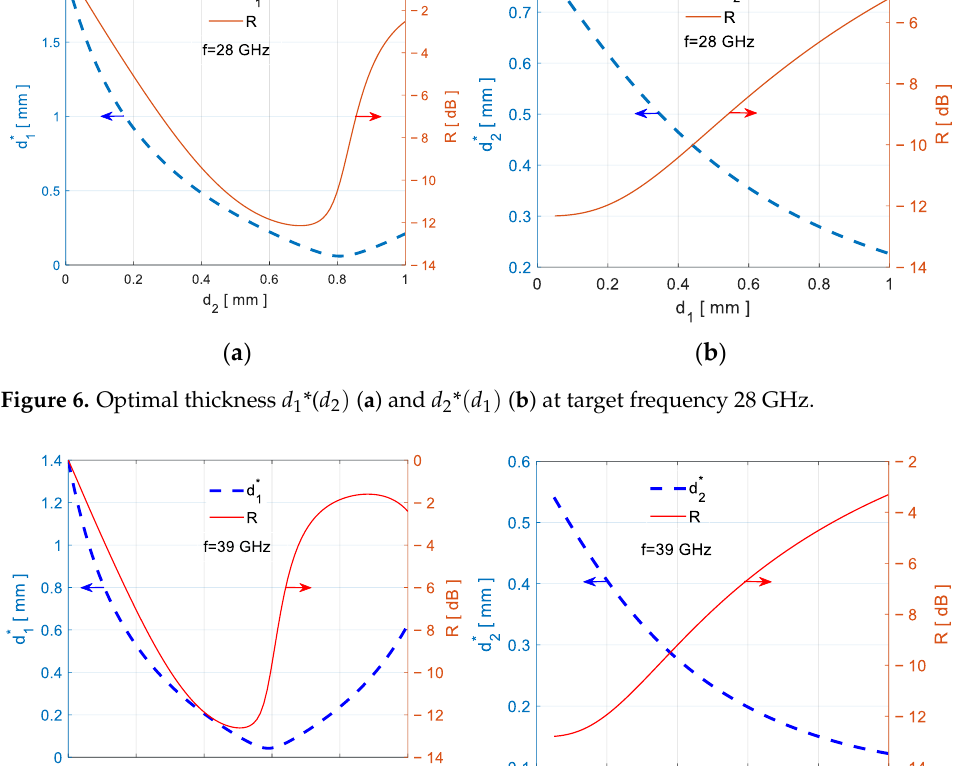
) ( a ) and d ( d ) ( b ) at target frequency of 39 1 *( d 2 2 * 1